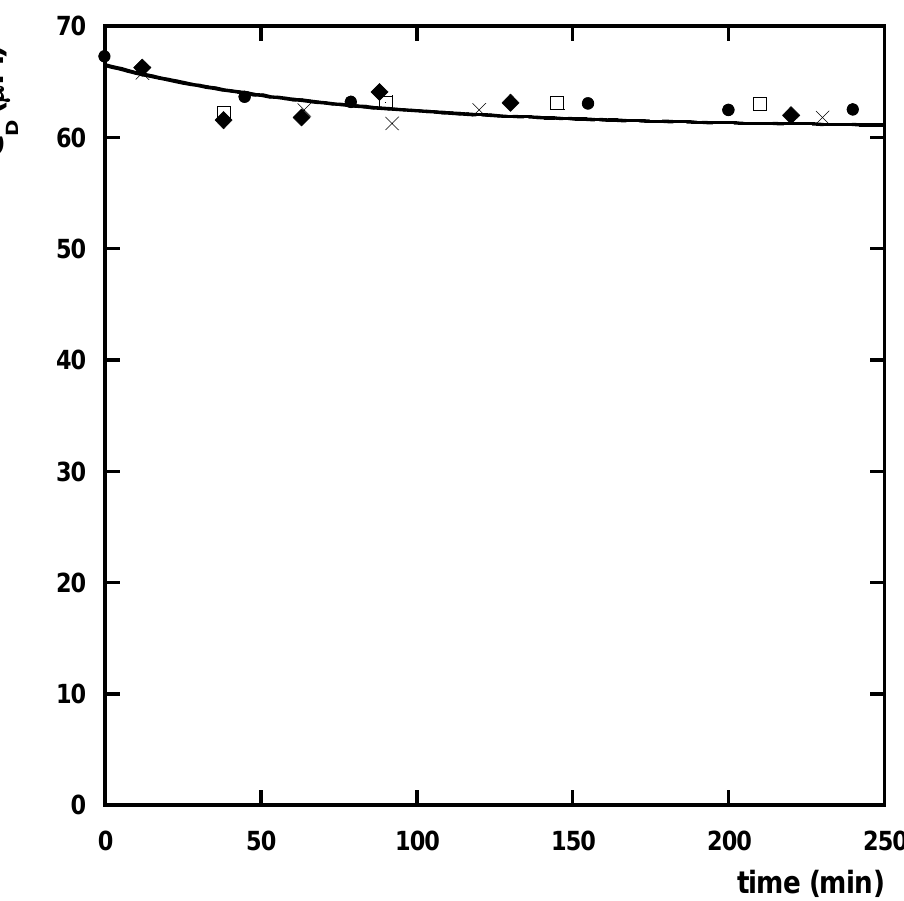
Figure 11. Diuron degradation kinetics profiles in the presence of MnO 2 at different temperatures, modeled by using Equation (11).